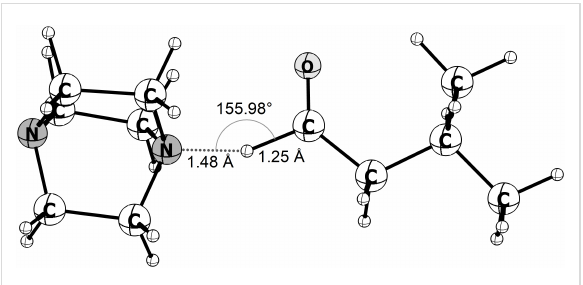
Figure 4: TS structure for the HAT reaction between the DABCO radical cation and isovaleraldehyde obtained at the DFT/M06-2X/cc- pVTZ level. Bond lengths and angle are